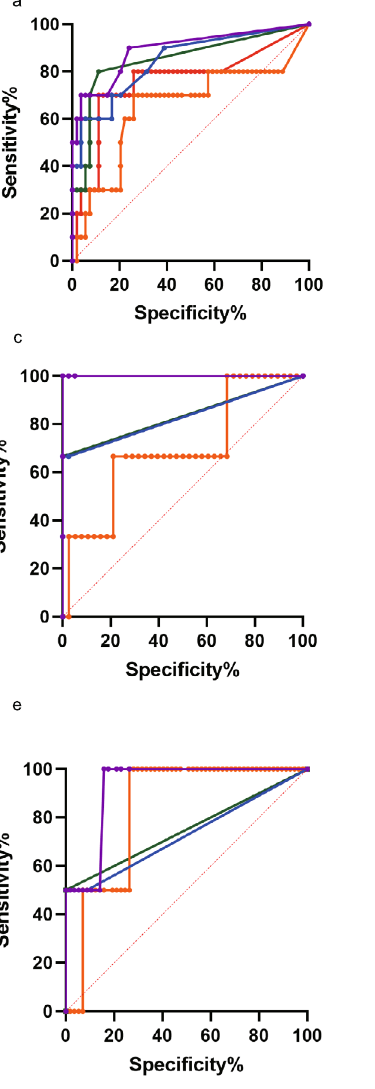
Fig. 4 | TAPE-seq analysis using PE2-nuclease and PEmax-nuclease with engi- neered pegRNAs. a Tagmentation rates at the HEK4 on-target site and various associated off-target sites after TAPE-seq using PE2, PE2-nuclease, or PEmax- nuclease with epegRNAs was performed; two-sided unpaired student t test. ( n =3 independenttransfection). b – f Venndiagramsshowing thenumber of and overlap between off-target loci predicted by TAPE-seq using PE2, PE2-nuclease, or PEmax- nuclease with epegRNAs, and validated off-target sites for the b HEK4 (+2G to T), c HEK4 (+3TAAins), d HBB (+4AtoT), e DNMT1 (+6GtoC),and f VEGFA (+5GtoT)